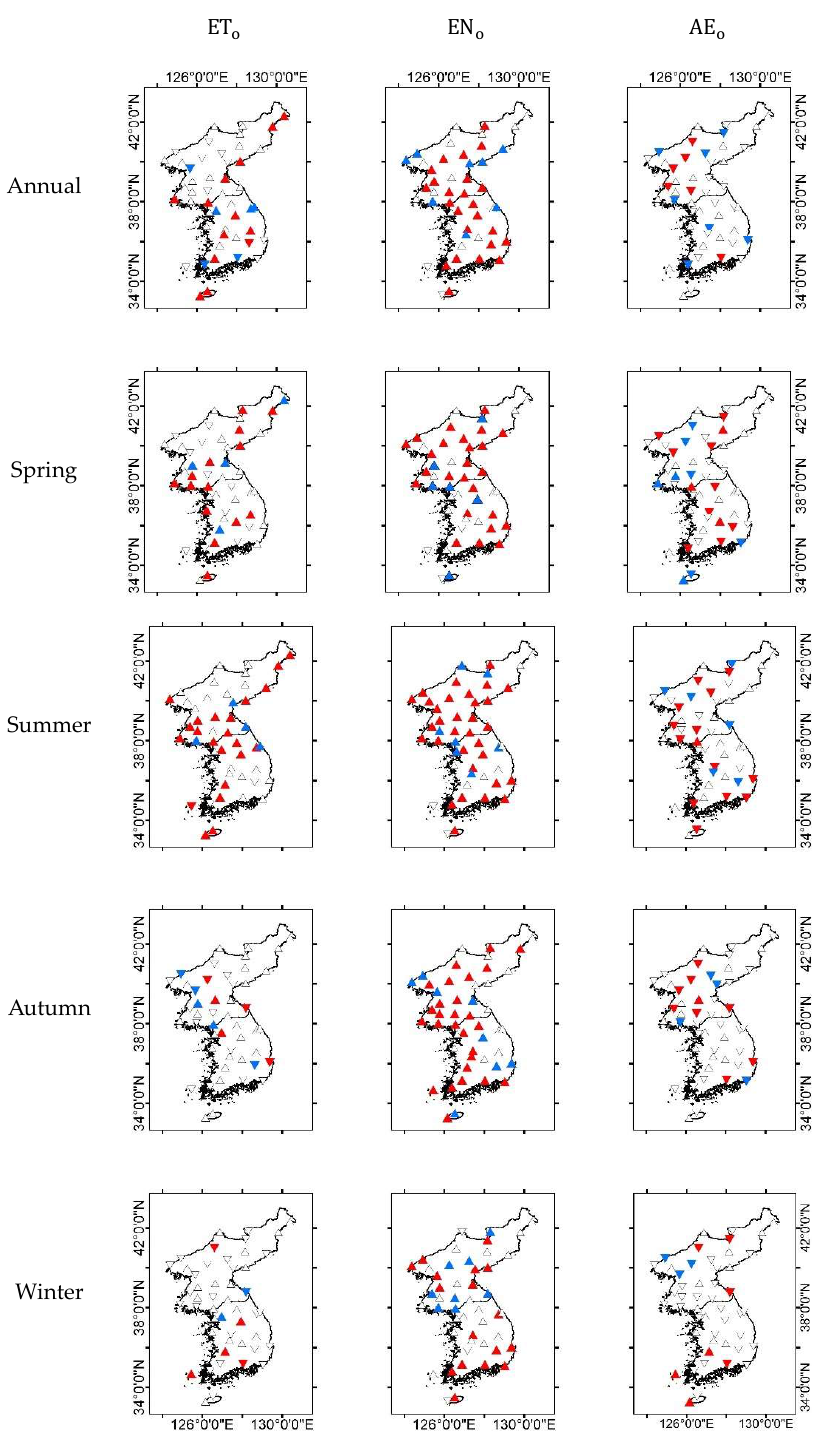
Figure 7. Spatial distribution of stations with increasing and decreasing trends according to the Mann–Kendall (MK) test on annual and seasonal ET o , EN o , and AE o during the period 1980 to 2017. Upward- and downward-pointing triangles indicate increasing and decreasing trends, respectively. Blue and red colors show the 90% and 95% confidence levels, respectively. The white color shows no significant trends.